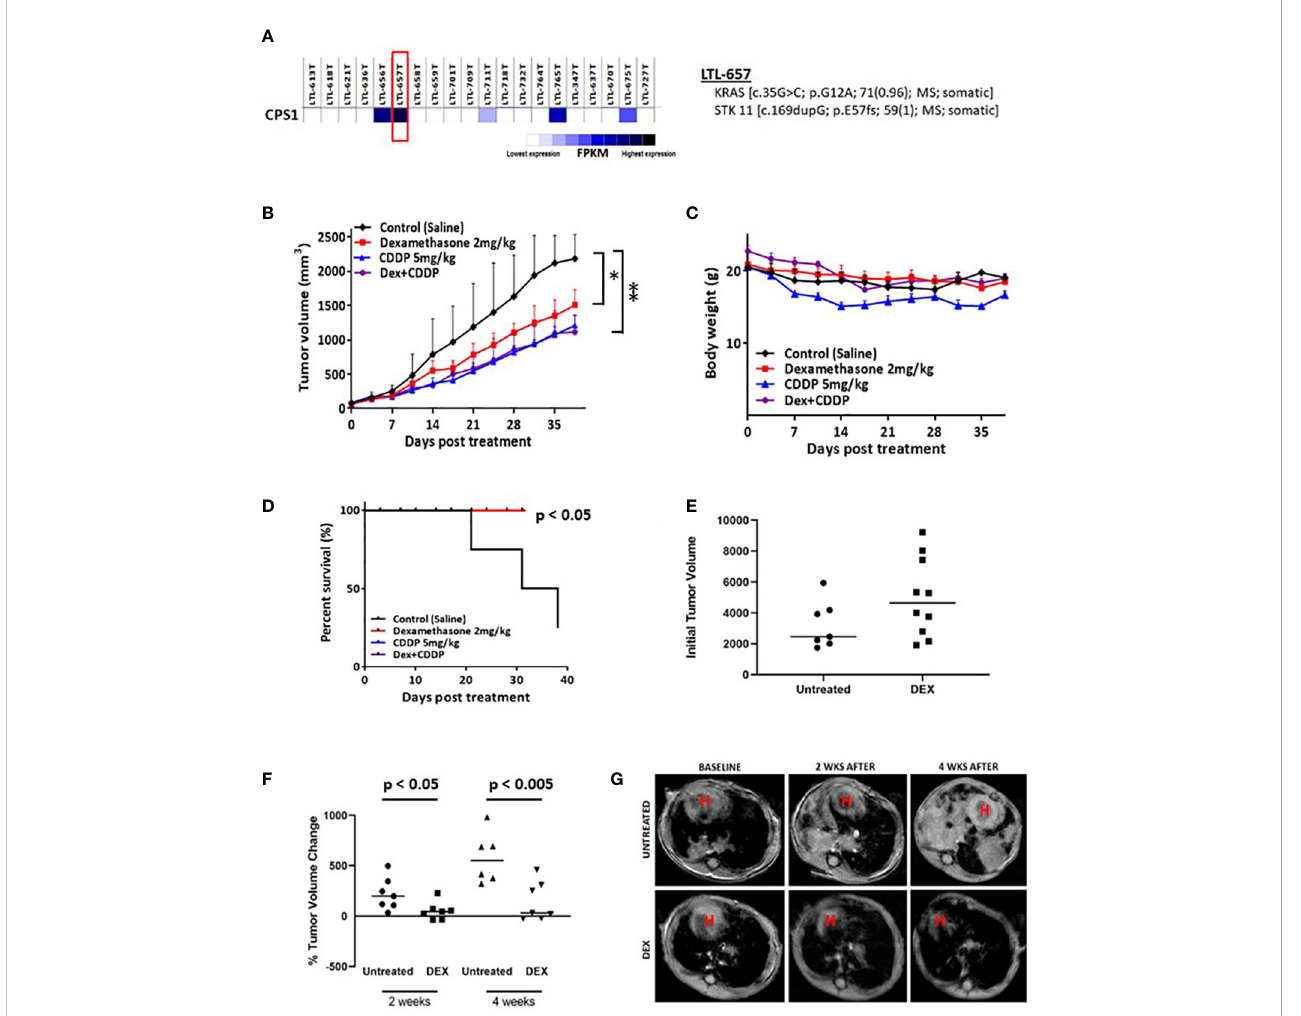
FIGURE 4 Biomarker driven choice of patient derived xenograft (PDX) and KL tumor GEMMs show response to DEX. (A) RNAseq data con fi rming high expression of CPS1. DNA seq data con fi rms and characterizes LKB1 mutation. (B) High CPS1 expressing PDX tumors were grown to approximately 250mm3 before DEX (red), platinum alone (blue), combination (purple) or vehicle (black) treatment started. Tumor growth curve for PDX tumors treated for fi ve weeks with DEX are shown. (C) Average body weight measurement for members of each cohort is plotted over the duration of the experiment. (D) Survival curves for each treatment group are plotted. (E) MRI estimated tumor volumes for mouse KL GEMM at baseline before DEX treatment. (F) MRI estimated tumor volumes plotted as percentage change in tumor volume compared to baseline at two weeks and four weeks. (G) Representative MRI of one control treated mouse and one DEX treated mouse over the course of the four week treatment. * means p-value < 0.05; ** means p-value <